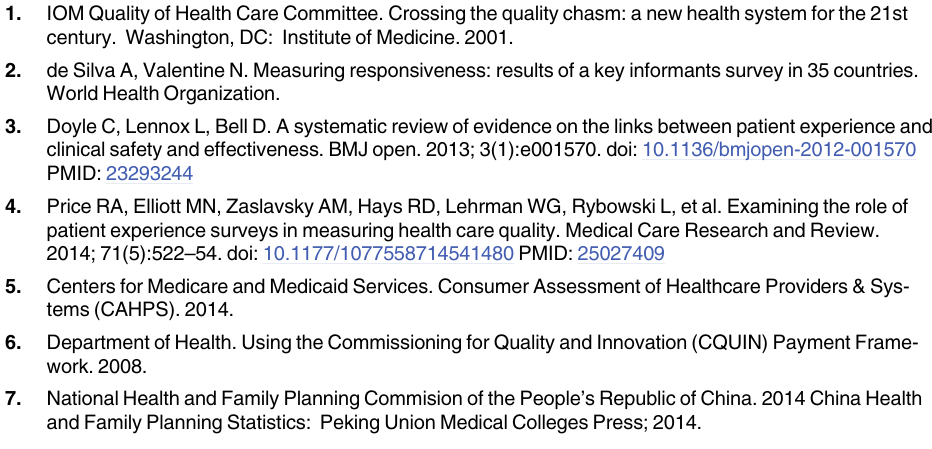
S1 Fig. Patient ratings by morning vs. afternoon visits: Tier 3 general hospitals. (TIF) S2 Fig. Patient ratings by Monday vs. Tuesday-Friday visits: Tier 3 general hospitals. (TIF) S3 Fig. Patient ratings by quartile of ambulatory volume of hospital: Tier 3 general hospi- tals.